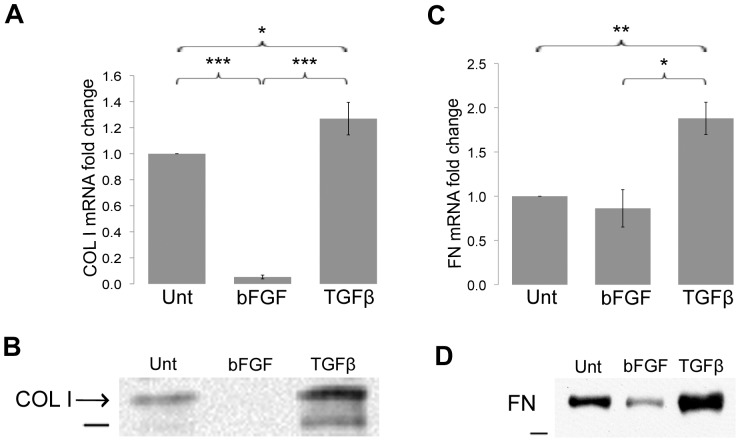
Effects of growth factors on ECM expression.Total RNA was isolated from untreated (Unt), bFGF-treated, or TGF-β-treated ADSCs after 4 days of treatment and qRT-PCR was performed for type I collagen (A) and fibronectin (C) using ubiquitin C as the normalization control. Graphs represent the average of multiple samples from three independent experiments; error bars indicate SEM. *p<0.05, **p<0.01, and ***p<0.001. (B) Anti-type I procollagen antibody was used to detect collagen in conditioned media separated in an 8% polyacrylamide-SDS gel. Sample loadings were normalized to total RNA amounts isolated from the cells. Blot is representative of three independent experiments. (D) Equivalent amounts of protein in urea lysates were separated in a 5% polyacrylamide-SDS gel, and fibronectin was detected with an anti-fibronectin monoclonal antibody. Anti-GAPDH was used to confirm equal loading (not shown). Blot is representative of two independent experiments. Dash represents 150 kD (B) or 250 kD (D).